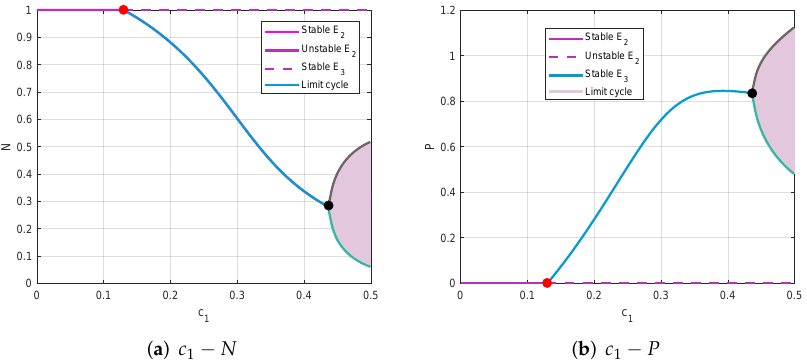
Figure 3. Bifurcation diagram of the system (3) with respect to the conversion rate or the predator birth rate due to predation ( c 1 ) with parameter values as in Table 2: ( a ) N state and ( b ) P state.